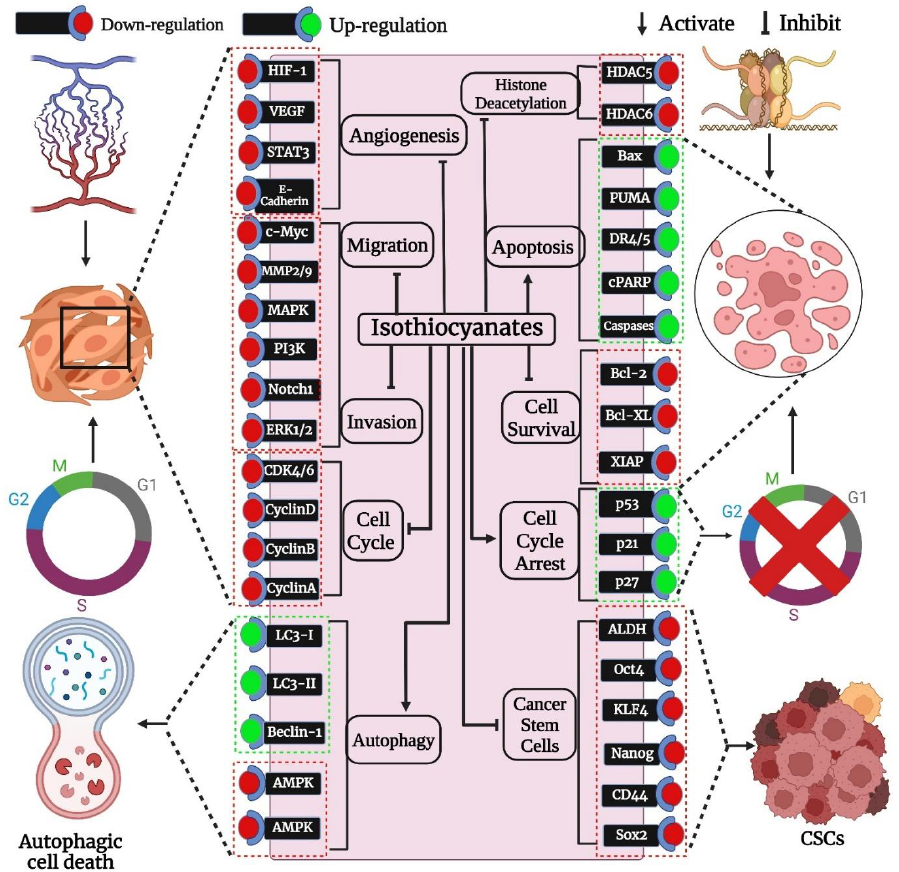
Figure 1. Representative figure highlighting the schematic illustration of the plausible mechanisms of action of ITCs against female-specific cancers. ITCs (SFN, BITC, and PEITC) effectively participate in inhibition of cell survival, migration, invasion, angiogenesis, and histone deacetylation, and lead to cell cycle arrest, apoptosis induction, and modulation of autophagy and cancer stem cells. The image was created in BioRender software (biorender.com).